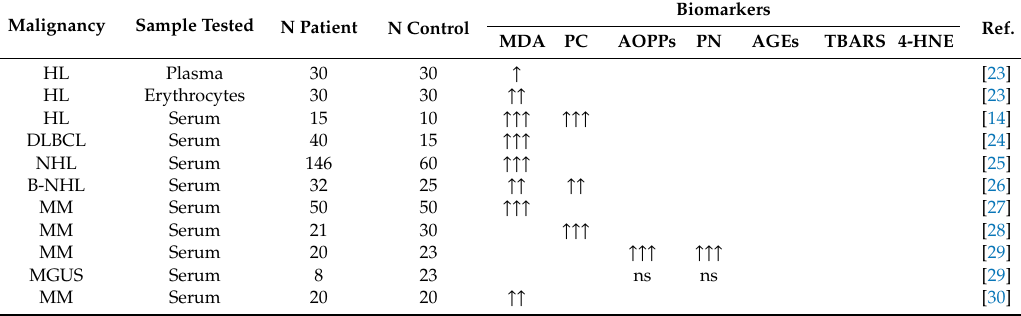
Figure 1. ( a ) The most common mechanisms of protein carbonylation. Direct processes include reactive oxygen species (ROS) attack, metal-catalyzed oxidation (MCO), and by oxidative cleavage of protein backbone (via the α -amidation pathway or through oxidation of glutamine side chains). The indirect mechanisms involve the reaction with ( b ) advanced glycation end-products (AGEs) and ( c ) advanced lipid peroxidation end-products (ALEs). Table 1. Major protein carbonylation and lipid peroxidation biomarker levels identified in patients with hematological